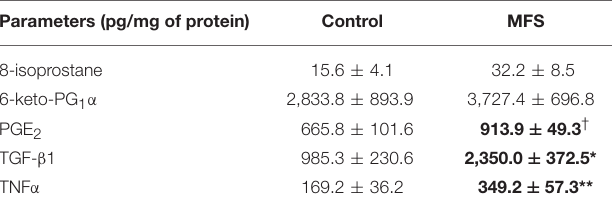
TABLE 3 | Inflammation, oxidative stress markers and vasodilator and vasoconstrictor prostaglandins products of the COX1 and COX2 respectively in control subjects and